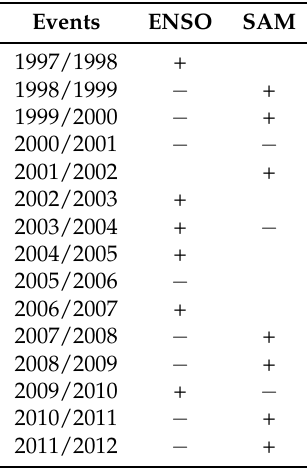
Table 1. List of ENSO and SAM events. El Niño and positive SAM events are represented by + and La Niña and negative SAM by − .